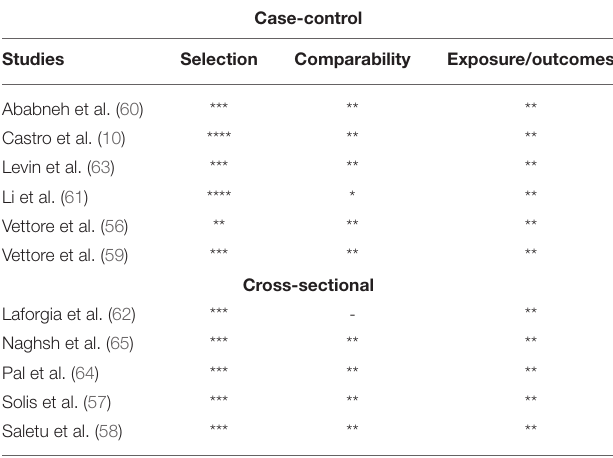
TABLE 2 | Summary of the methodological quality analysis according to the Newcastle-Ottawa protocol to assess the risk of bias of the cross-sectional and case-control